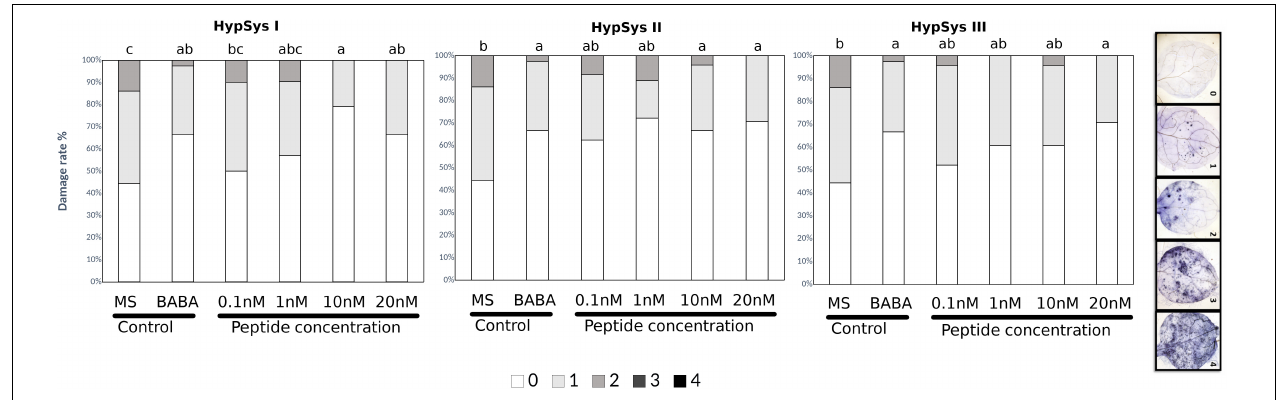
FIGURE 2 | HypSys peptides induced-resistance assays against Plectosphaerella cucumerina in Arabidopsis plants. Infection levels 5 days after inoculation quantified by a disease rating in trypan blue stained leaves, measured as a percentage of the infected leaf surface. Arabidopsis Col-0 plants were treated with increasing concentrations of HypSysI, HypSysII, and HypSysII (0.1, 1, 10, and 20 nM) 24 h before infection with 1 µ l droplets of 5 × 10E3 spores/ml of P. cucumerina BMM. ß-amino butyric acid (BABA) at 1 ppm was used as a positive control. Colors mean % of diseased leaves in a scale (0 = healthy leaves; 1 = leaves with less than 25% of diseased surface; 2 = leaves with 25–50%; 3 = leaves with 50–75% of the diseased surface, 4 = leaves with more than 75% of the surface diseased). Different letters indicate statistically significant differences (ANOVA, Fisher’s Least Significant Difference (LSD) test; P < 0.05, n = 24). The experiment had 6 plants per treatment and was repeated at least three times with similar results.